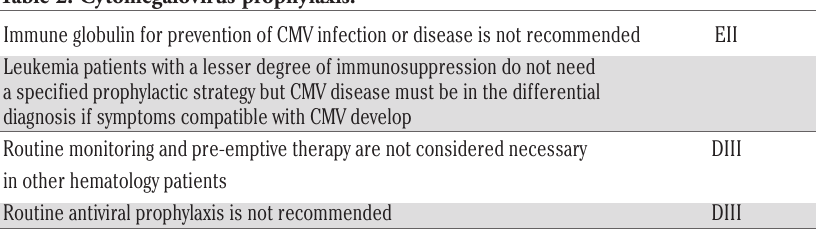
Table 2. Cytomegalovirus